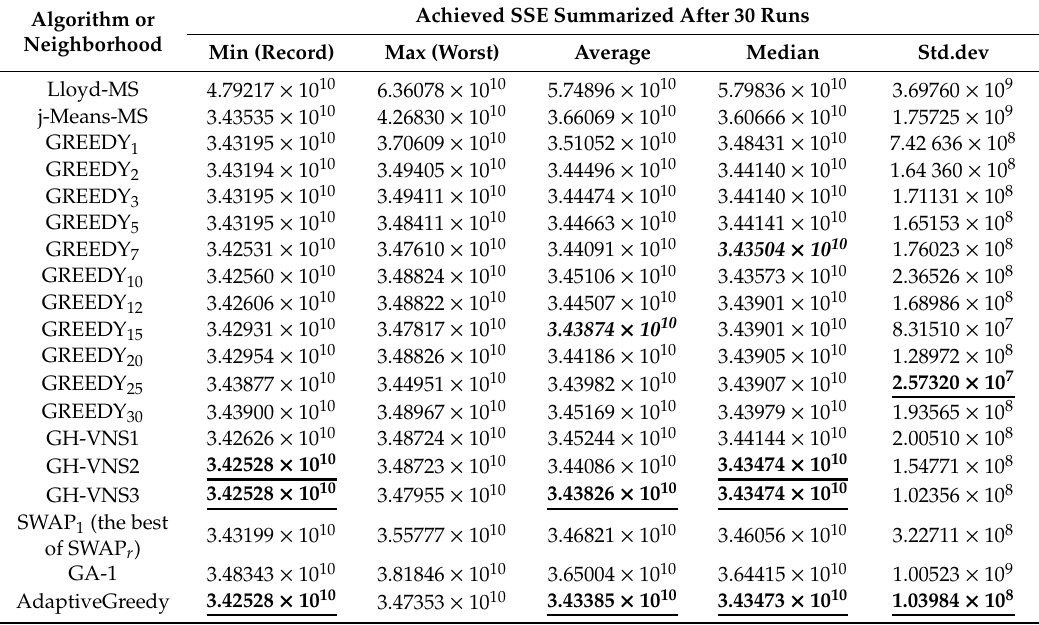
Table A4. Comparative results for Mopsi-Finland data set. 13,467 data vectors in R 2 , k = 30 clusters, time limitation 5